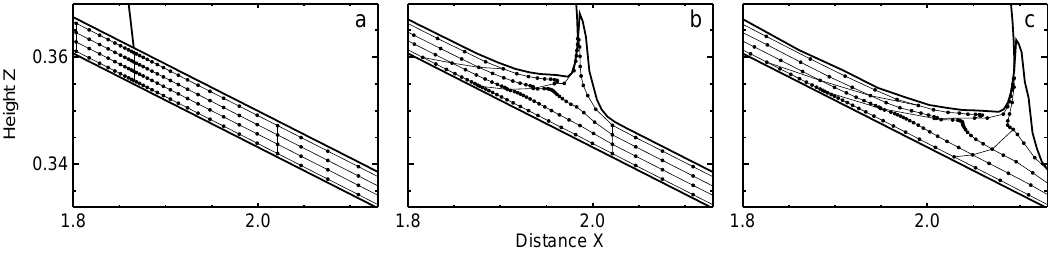
Fig. 5. Experiment B: Relatively soft and moderately non-linear till ( m = 3, B = 0 . 35): Deformation of originally parallel internal sediment layers are shown for dimensionless times T equal to 0 (a) , 8 (b) and 16 (c) . The dots represent material particles throughout the pictures. The topmost layer shows the strongest deformation due to the uplifting of sediment needed to form the bulge (b–d). After a while the bulge is stable in amplitude and shape, and only a small uplift of the sediment takes place at the down-facing side of the bulge (c). Three former vertical straight lines (solid) illustrate how such lines deform with time.